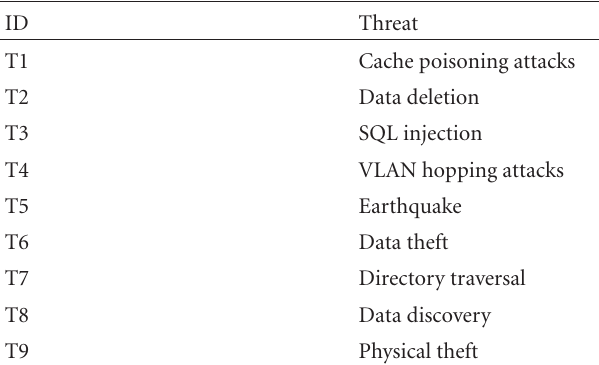
Table 7: Threats.